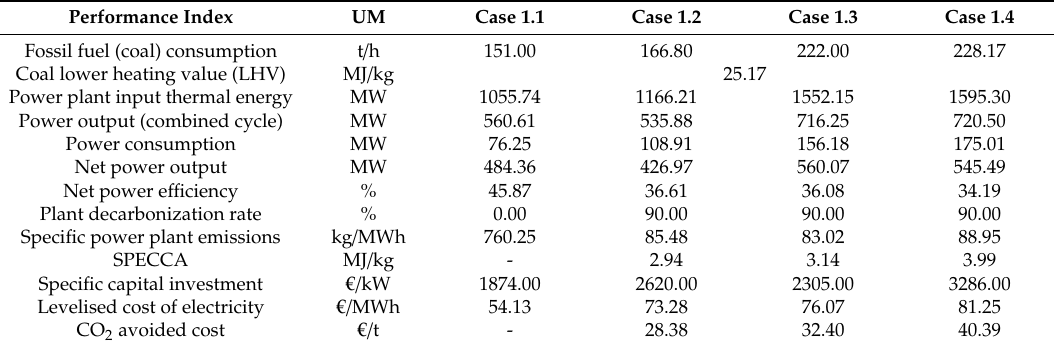
Table 2. Gasification power plants techno-economic and environmental performance